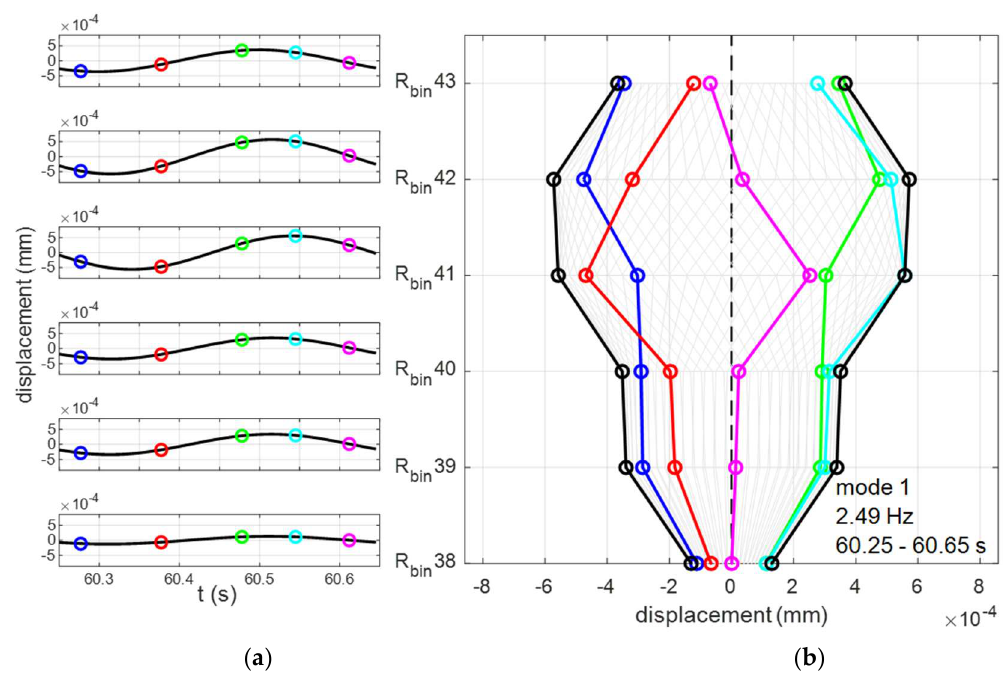
Figure 20. ( a ) Displacement–time histories of the Rbins, from 60.25 to 60.65 s (0.4 s), corresponding to a period of the fundamental frequency of the structure (2.49 Hz). The colored circles represent five different time instants. ( b ) Displacement of the five time instants for each of the Rbins; the black lines correspond to the maximum and minimum displacements of the 0.4 s fragment.